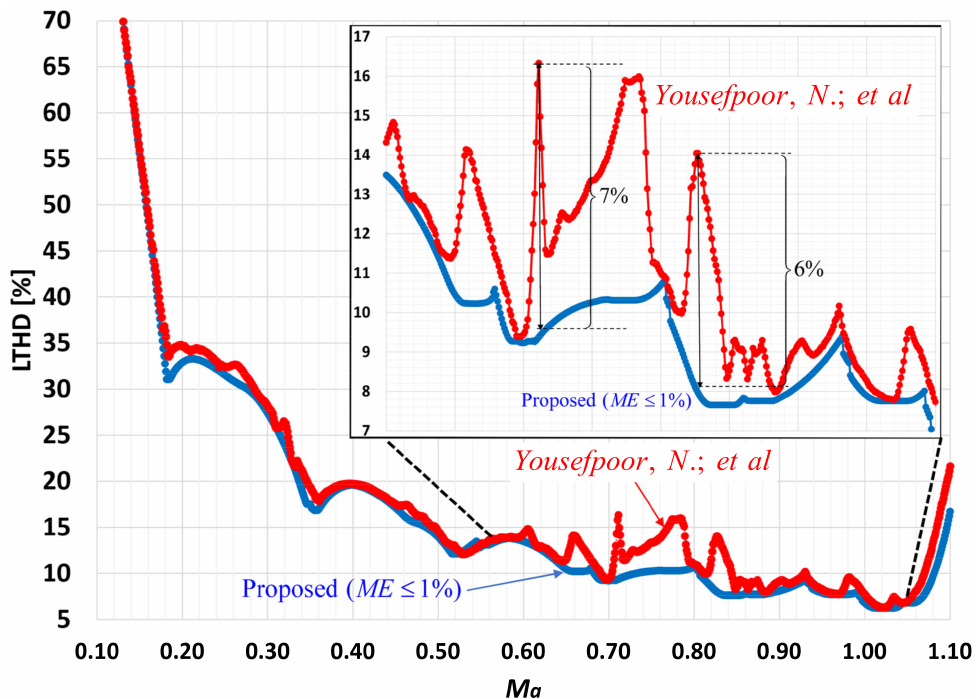
Figure 8. LTHD-optimal results (actual LTHD vs. ma ) for N = 7: analytical (proposed) vs. obtained in [9].